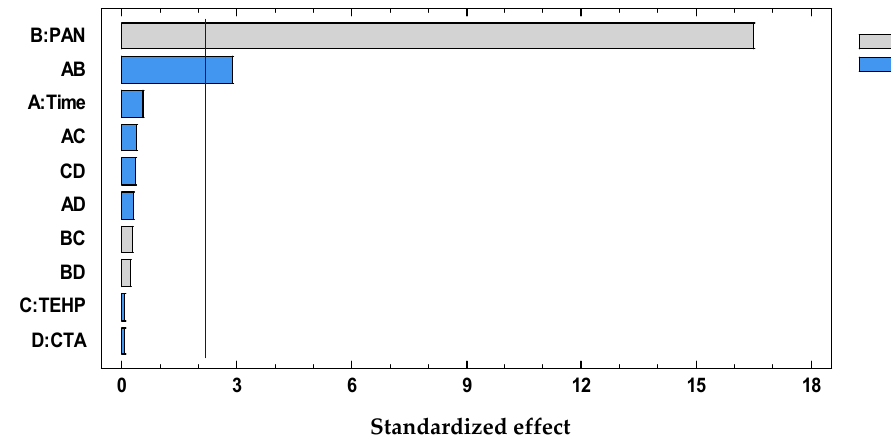
Figure 6. Desirability pareto chart after DoE analysis for the system PAN–Pb(II). Table 4. Analysis of variance (ANOVA) results for the system PAN-Pb(II).